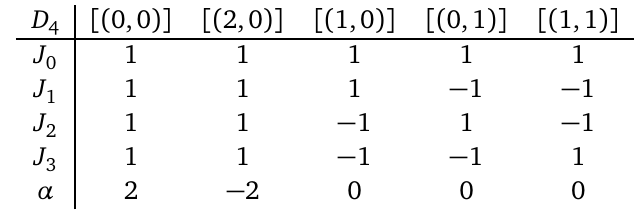
, where q = exp { i 2 π/ 4 } 4